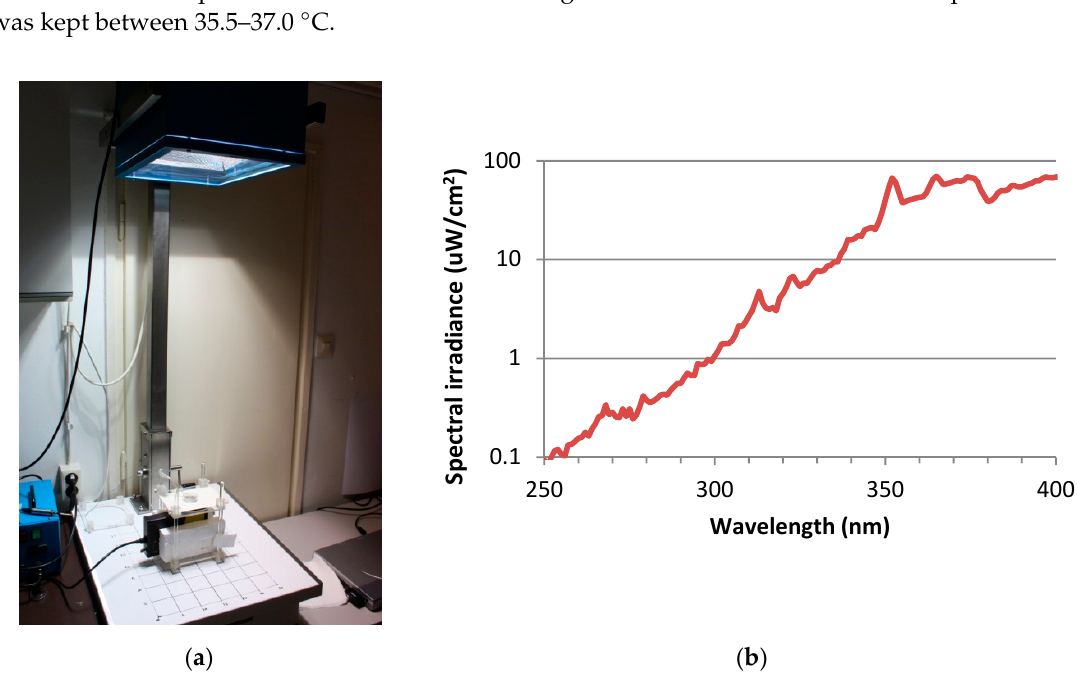
Figure 1. ( a ) Spectral measurement the UV exposure system of the solar simulator (Hönle SOL-500) equipped with the wavelength filter. ( b ) Spectral irradiance of solar simulator filtered by the lid of the petridish.